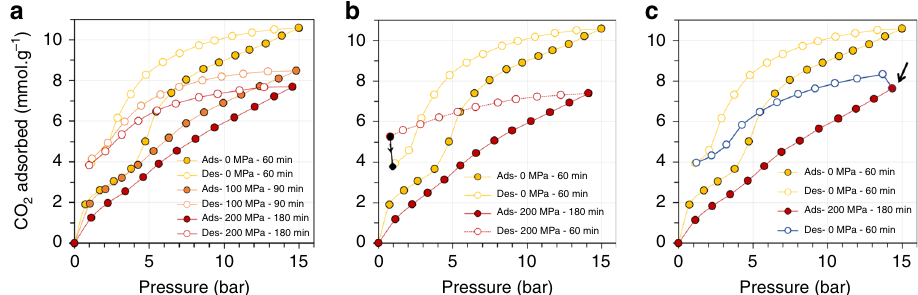
Fig. 4 Regeneration of MIL-53(Al). a – c CO 2 adsorption – desorption isotherms at 303 K a for the unconstrained MIL-53(Al) (yellow), and under a mechanical constraint of 100 (orange) and 200 MPa (red) with an equilibrium time set at 60, 90, and 180 minutes per point, respectively b under 200 MPa with an equilibrium time set at 180 minutes per point for adsorption (red full line) and 60 minutes per point for desorption (dashed red line). Filled black circles indicate the evolution of CO 2 uptake when allowing the system to further equilibrate for 10 hours c under 200 MPa with an equilibrium set at 180 minutes per point for adsorption (red full line) and after release of the mechanical constraint under gas pressure with an equilibrium time for desorption set at 60 minutes per point (blue line). The black arrow indicates the point on the isotherm at which the mechanical pressure has been released. b , c CO 2 adsorption – desorption isotherm for the unconstrained MIL-53(Al) (yellow) with an equilibrium time set at 60 minutes is given for comparison. a – c Filled and open circles represent adsorption and